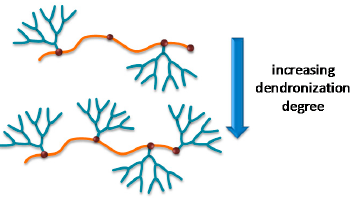
Figure 4. Schematic representation of the dendronization degree.